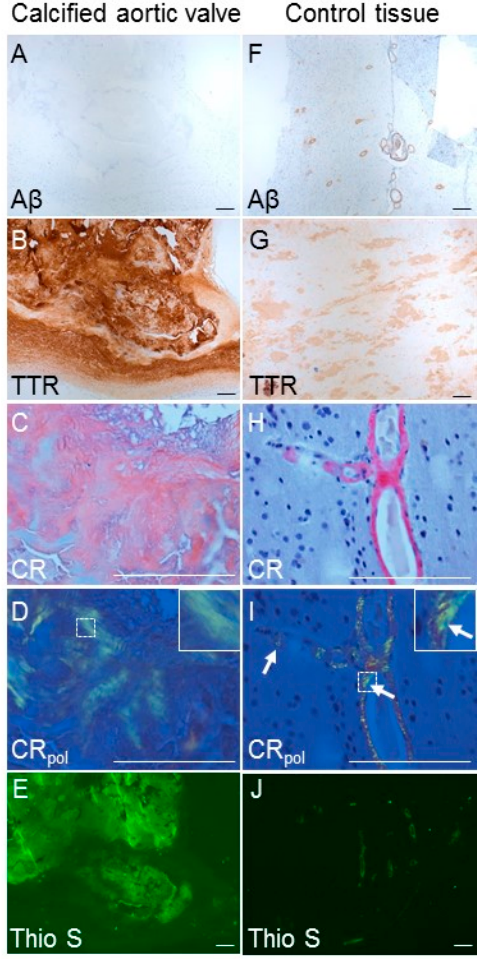
Figure 5. Transthyretin (TTR)-positive staining associates with Thioflavin S-positivity in human calcified aortic valves. Representative ( A ) β -amyloid (A β ), ( B ) TTR, ( C , D ) Congo Red (CR—bright field, CR pol —polarized light) and ( E ) Thioflavin S (Thio S) fluorescence images of human calcified aortic valves (decalcified) of patient with aortic stenosis. One donor out of n = 9 is shown. ( G ) Positive control for TTR (amyloid within the ligamentum flavum). ( F , H – J ) Brain tissue with cerebral amyloid angiopathy as positive control for A β ( F ), Congo Red ( H , I ) and Thio S ( J ). Arrow in J indicates Congo Red-positive signal showing areas with the typical “apple-green birefringence” in polarized light. Insert in D and I shows a higher magnification of the dashed area. Bar: 200 μ m.